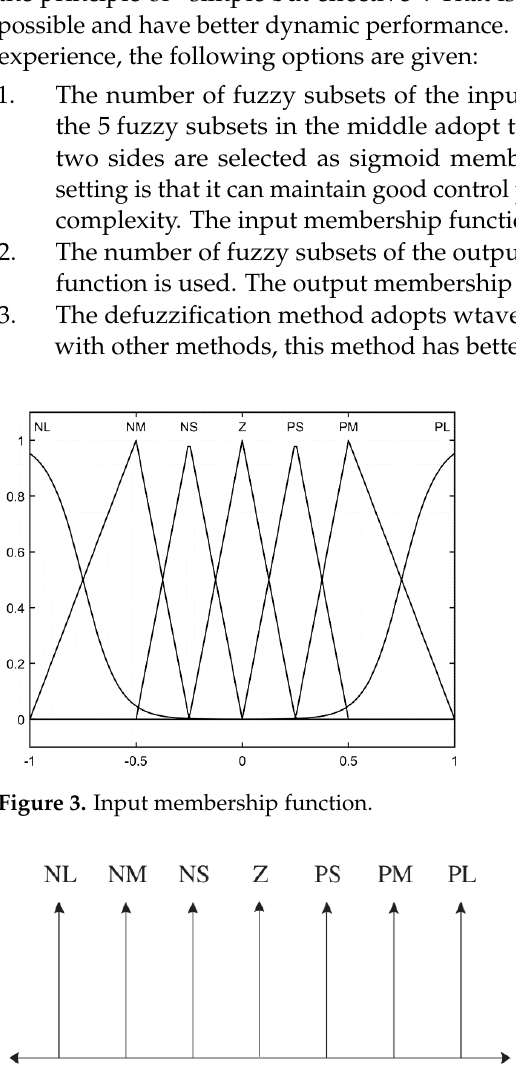
f ( t ) as control inputs. t